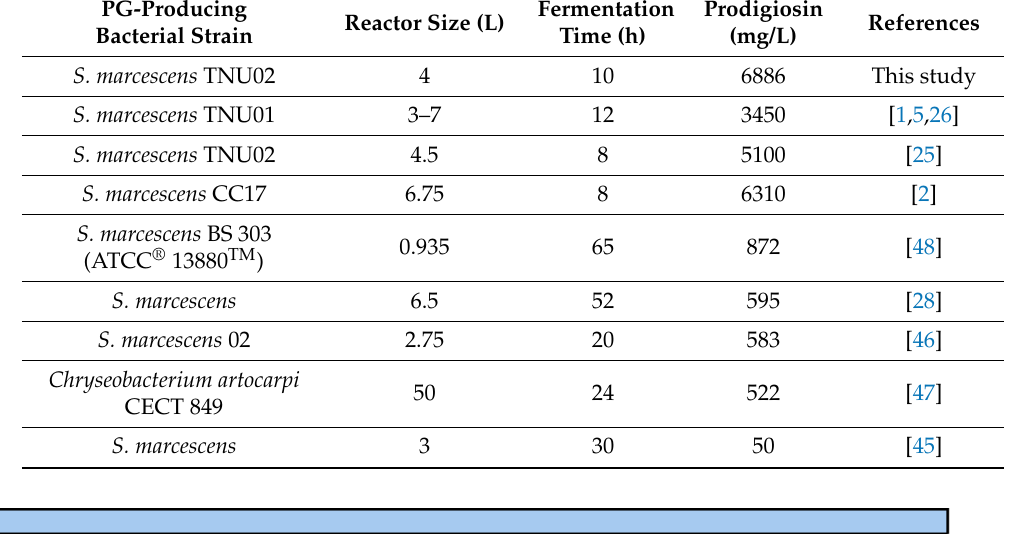
Table 4. Research for scale-up prodigiosin production in a bioreactor system.